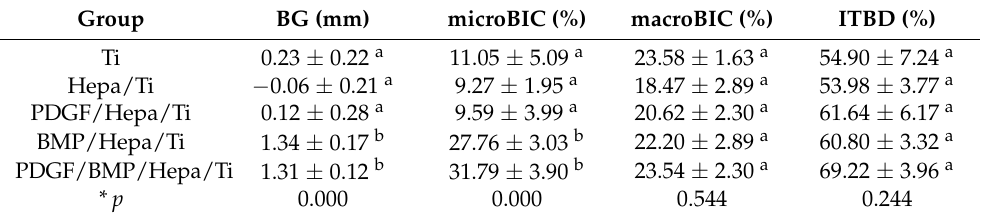
Figure 10. Microthread defect area in the BMP/Hepa/Ti and PDGF/BMP/Hepa/Ti groups. The BMP/Hepa/Ti and PDGF/BMP/Hepa/Ti group exhibited successful osseointegration in lingual portions. ( a , d ) lingual microthread portion; ( c , f ) buccal microthread portion; ( a – c ) BMP/Hepa/Ti group; ( d – f ) PDGF/BMP/Hepa/Ti group. ( a , c , d , f ) ×40 magnification, ( b , e ) ×12.5 magnification. Table 3. Results of histometric analysis performed at 8 weeks after surgery. (Buccal bone level, BIC on macrothreads, and bone density on macrothreads; n = 8).